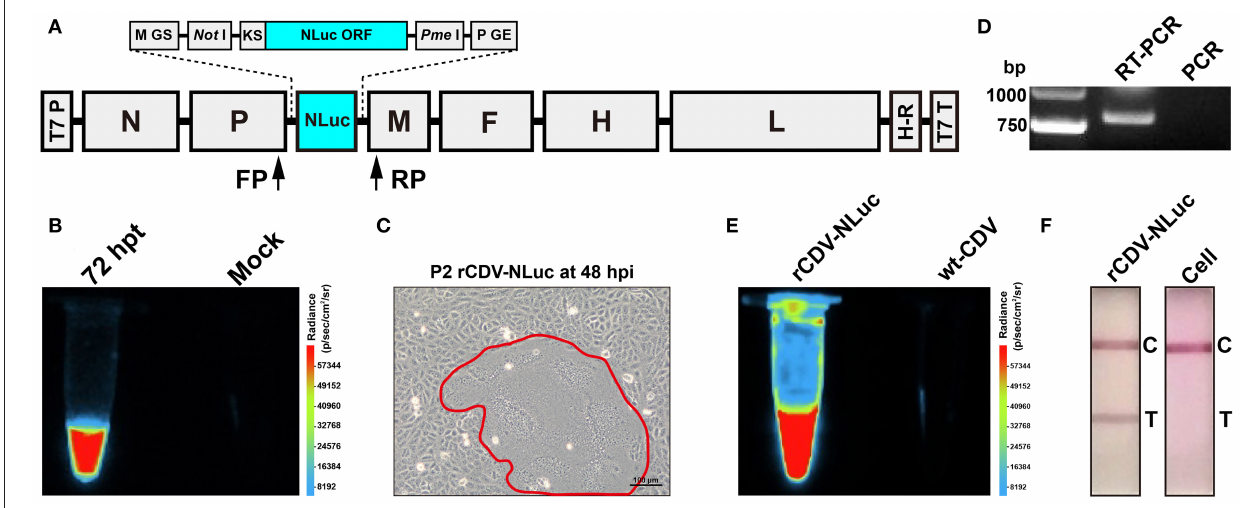
FIGURE 1 | Construction and identification of the rCDV-NLuc. Schematic representation of rCDV-NLuc cDNA clone (A) . GS: gene start; GE: gene end; KS: Kozak sequence; NLuc ORF: NanoLuc ® luciferase open reading frame; T7 P: T7 promoter; H-R: hepatitis delta virus ribozyme; T7 T: T7 terminator; FP: forward primer; RP: reverse primer. Luminescence assay of BSR-T7/5 cells co-transfected with four plasmids (B) . Syncytium formation (encircled by closed line) on a VDS cell monolayer infected with the P2 rCDV-NLuc at 48 hpi (C) . RT-PCR and PCR analyses of the P5 rCDV-NLuc using the FP/RP primers (D) . Luminescence assays of the P6 rCDV-NLuc and the wt-CDV (E) . Detection of rCDV-NLuc- and non-infected cells by test strips (F) . T, test; C,